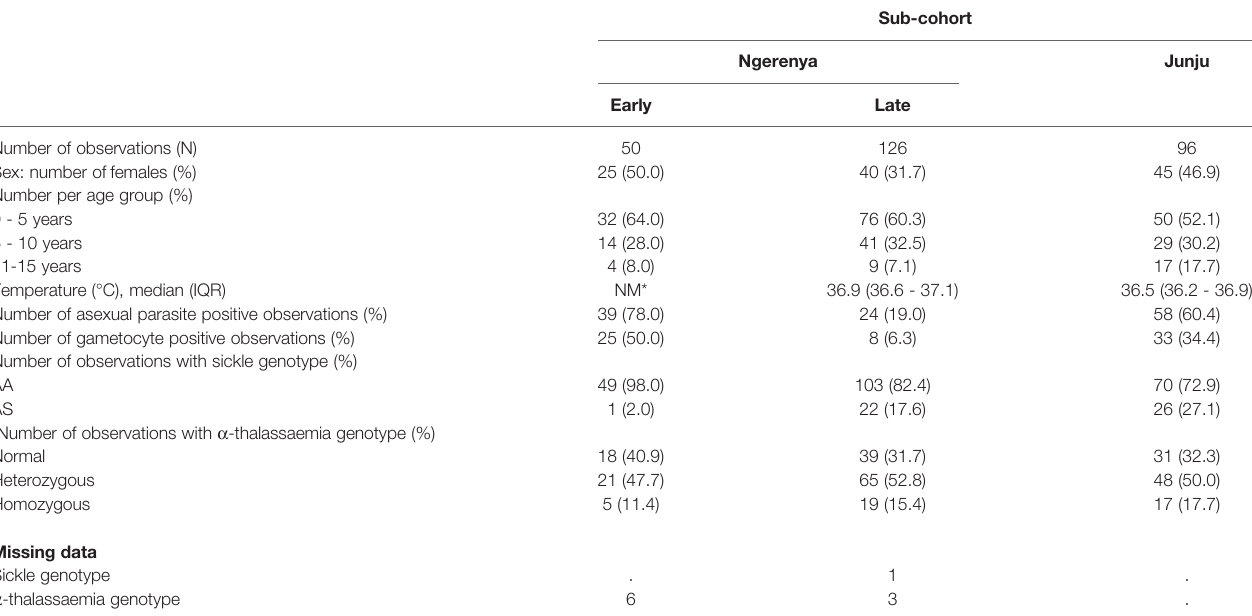
TABLE 2 | Demographic characteristics of observations from a subset of the KMLC cohort study